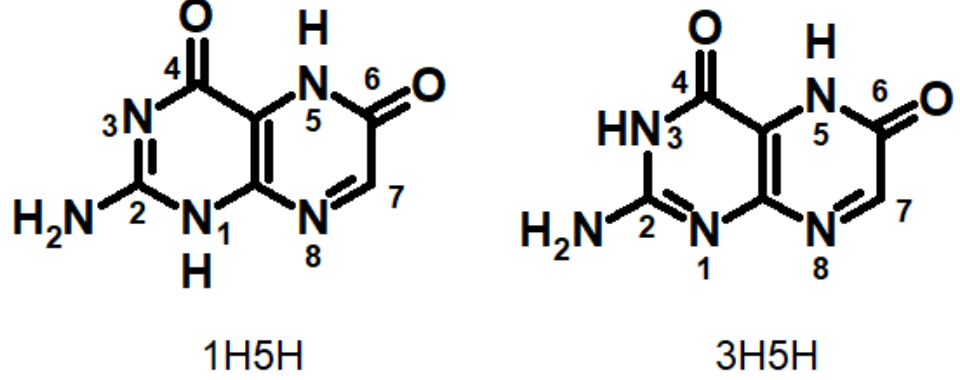
Figure 17. Chemical formulas of 1H5H and 3H5H xanthopterin tautomers.